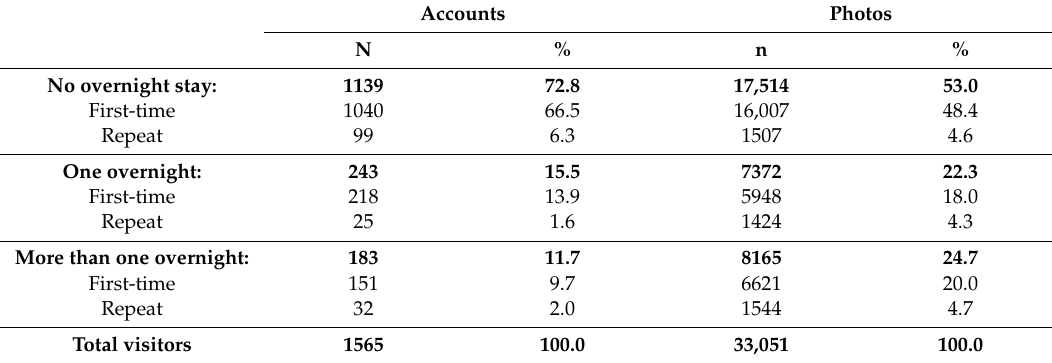
Figure 5. Flickr photos, taken between 2010 and 2017 in the historic centre of Toledo. Source: Authors’ own elaboration. Table 2. Distribution of accounts and photos kept for analysis by type of visitor.